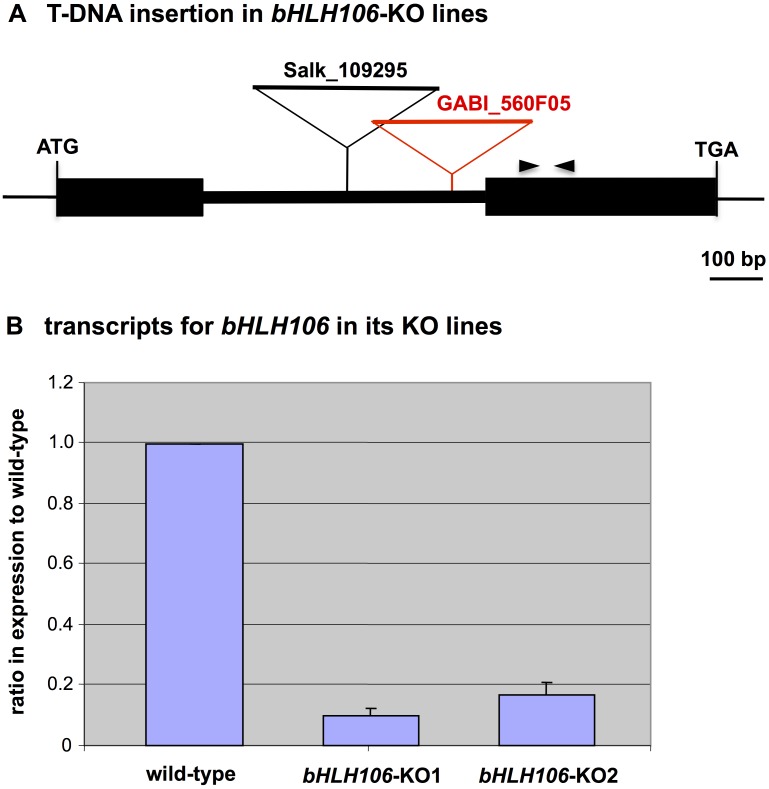

bHLH106-knockout (KO) lines.(A) Integrated locations of T-DNA for gene disruption at the bHLH106 locus in SALK_109295 and GABI_560F05, designated as bHLH106-KO1 and bHLH106-KO2, respectively. The pair of opposing arrowheads shows the primers employed for RT-PCR. (B) bHLH106 gene expression in KO plants. Expression was determined by real-time RT-PCR and normalized using ACTIN2 (ACT2). Error bars represent ±SEM from four experimental replicates.